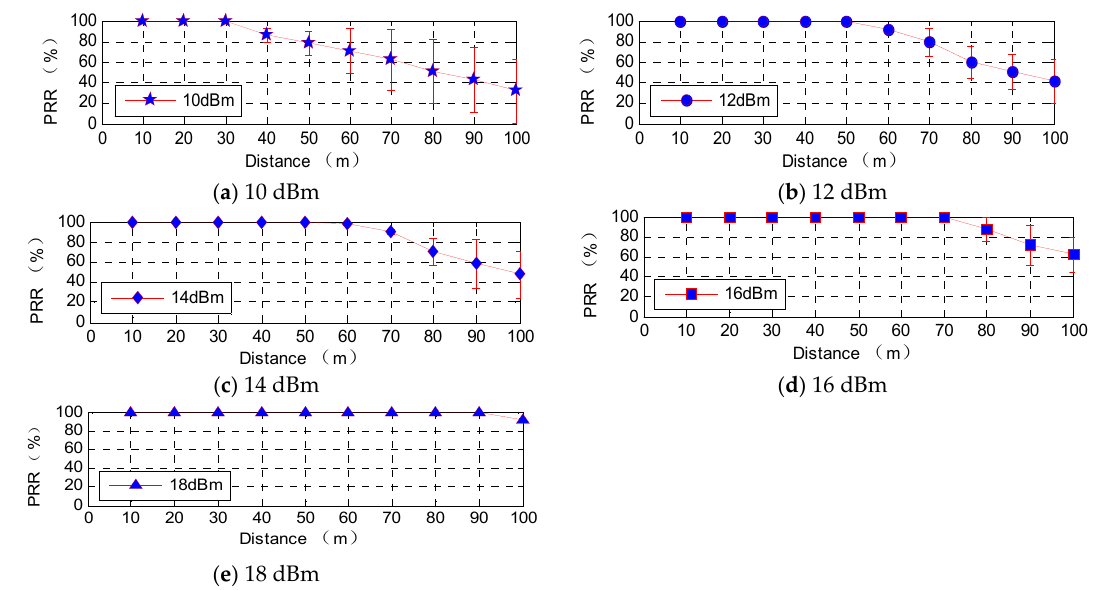
Figure 11. Wireless module data reception with different transmission power levels.